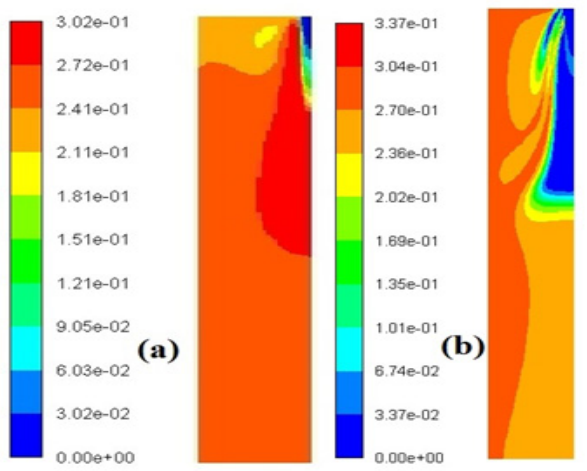
Figure 29. Contours of CO content in mole fraction where the right vertical line represents the axis of symmetry: ( a ) Reactor 1 and ( b ) Reactor 2.